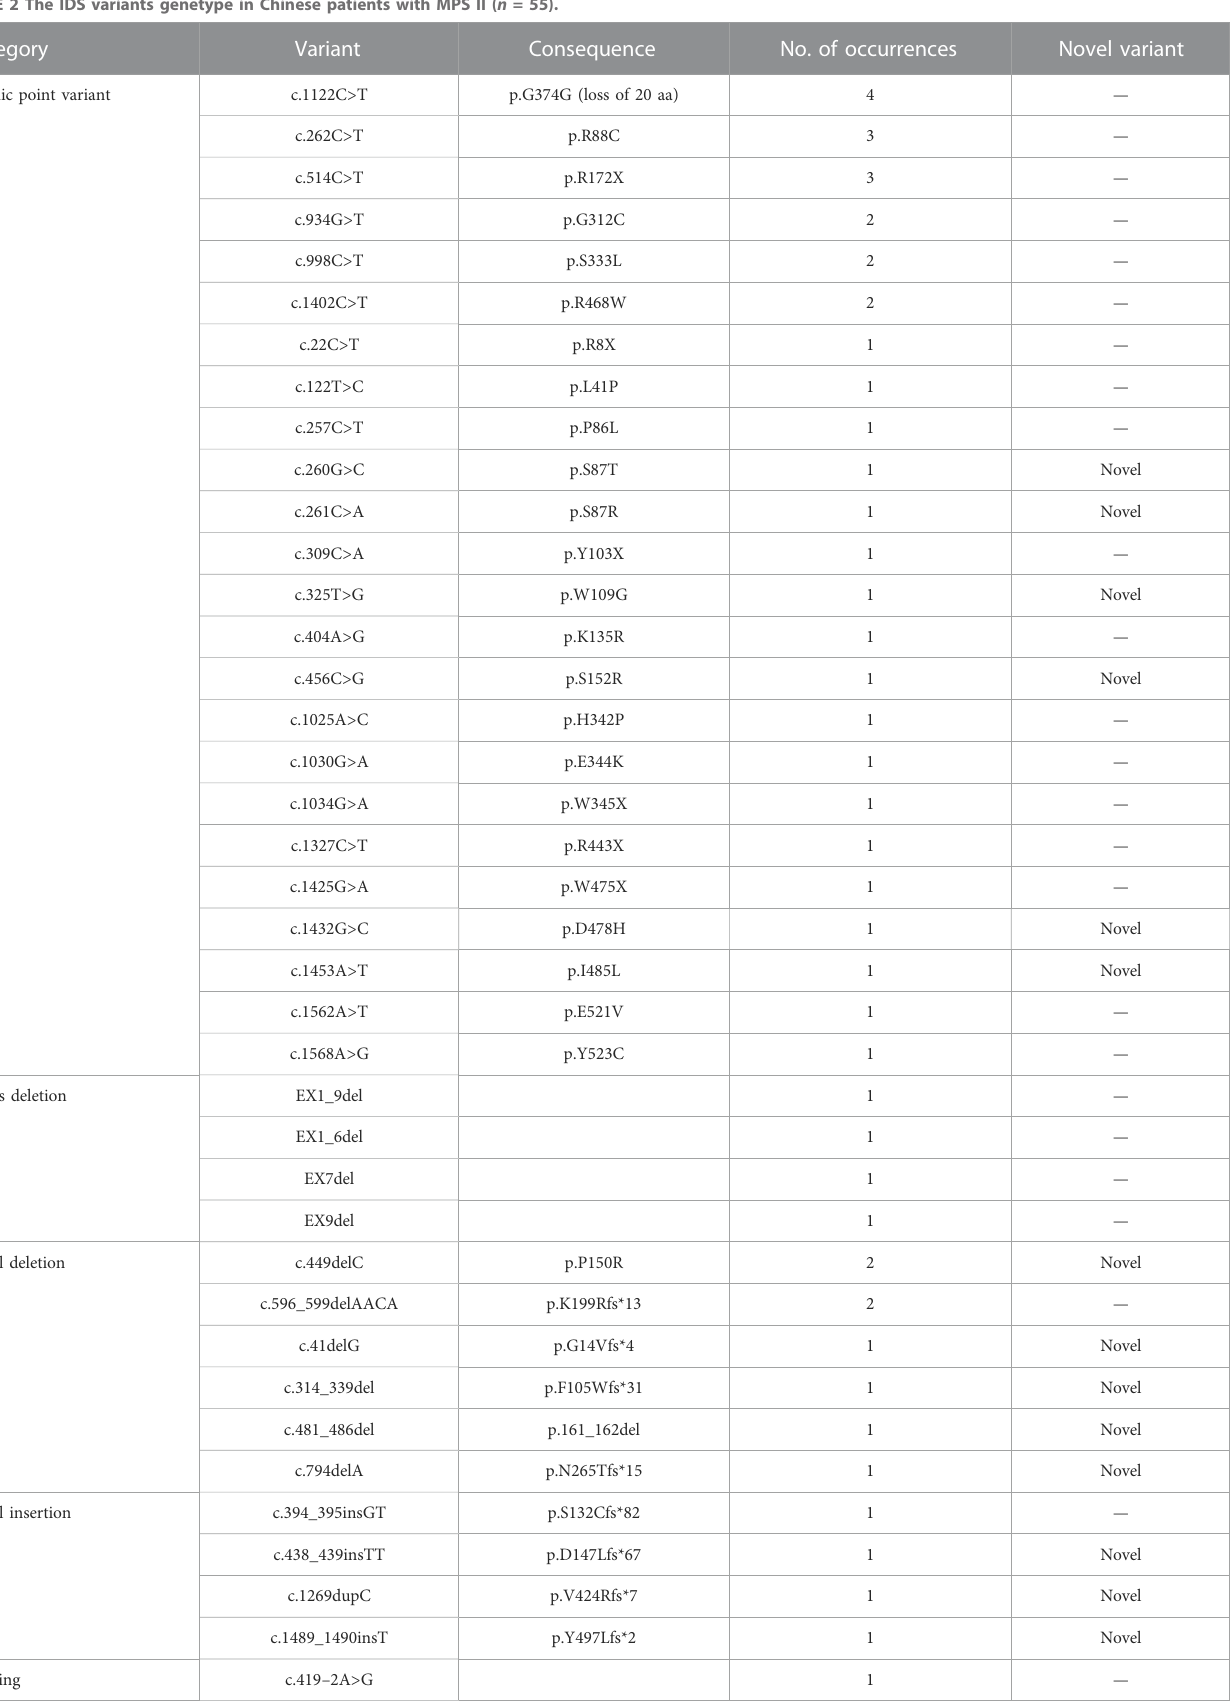
TABLE 2 The IDS variants genetype in Chinese patients with MPS II ( n = 55).